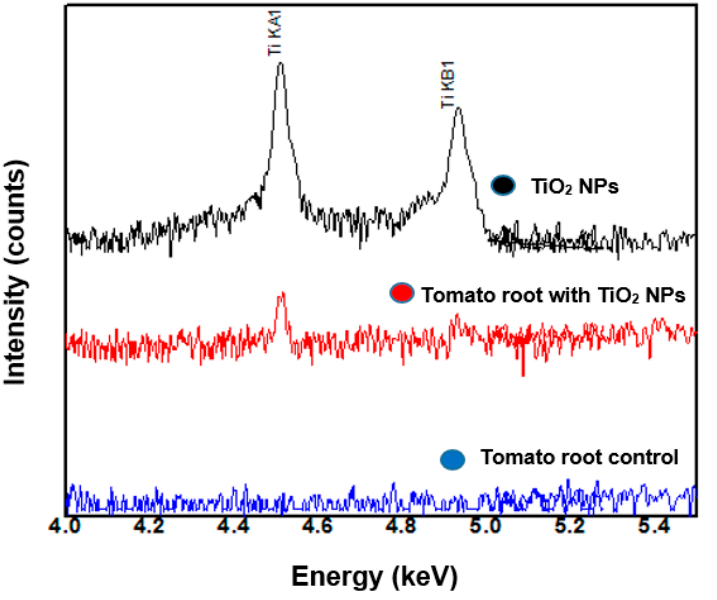
Figure 4. WDXRF analyses of tomato root control (blue line), and the root exposed to 20 mg/L of TiO 2 NPs (red line) and TiO 2 NPs (black line).